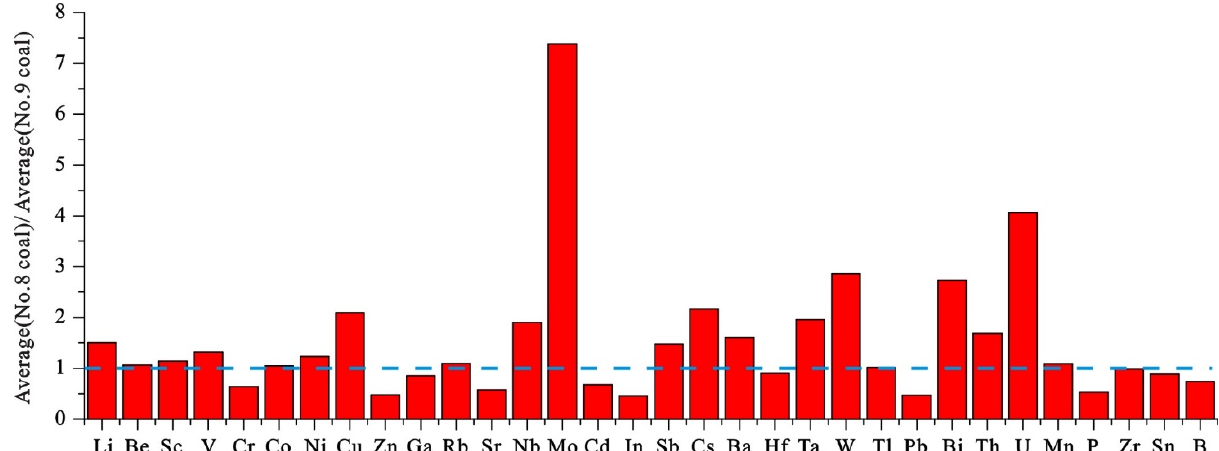
Figure 7. Li content distribution of No. 8 coal .